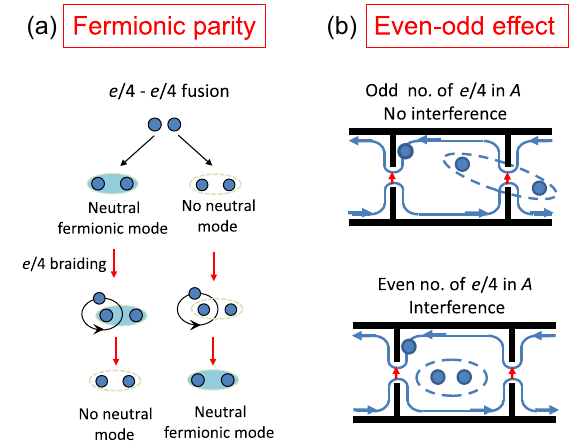
FIG. 1. Fermion parity and the non-Abelian even-odd effect. (a) The fusion of two non-Abelian e= 4 quasiparticles has two possible outcomes, one with and one without a neutral fermionic mode. The fermion parity is a quantum number associated with an even number of such quasiparticles. It is changed when one constituent e= 4 quasiparticle is braided by an external e= 4 quasiparticle. (b) When e= 4 quasiparticles backscatter from the lower to the upper edge of the Hall bar at the two constrictions, the outcome depends dramatically on the parity of e= 4 quasi- particles inside the interferometer. If their number is even, quasiparticles propagating along two possible paths interfere akin to the familiar double slit interference. If this number is odd, the interference disappears since with each tunneling quasipar- ticle the fermion parity is either switched or not, depending on which path is taken. The final quantum states are therefore orthogonal to one another, which precludes